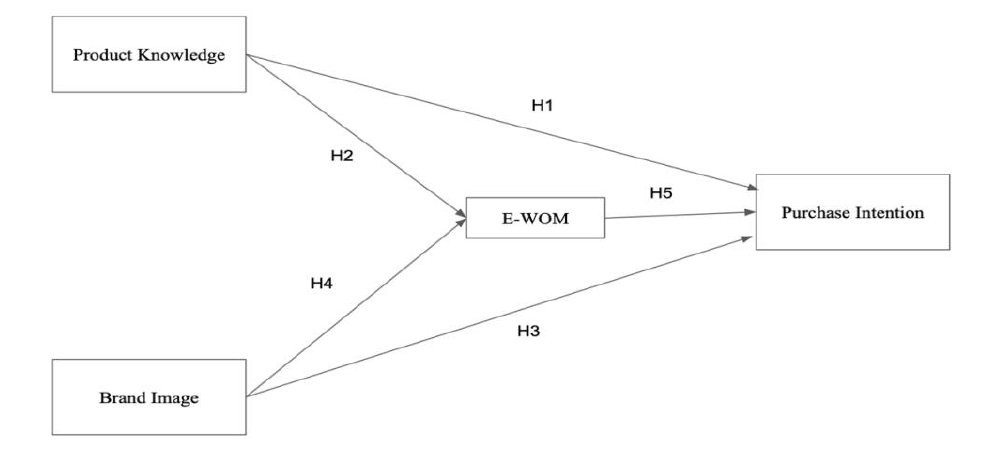
Figure 1: Research